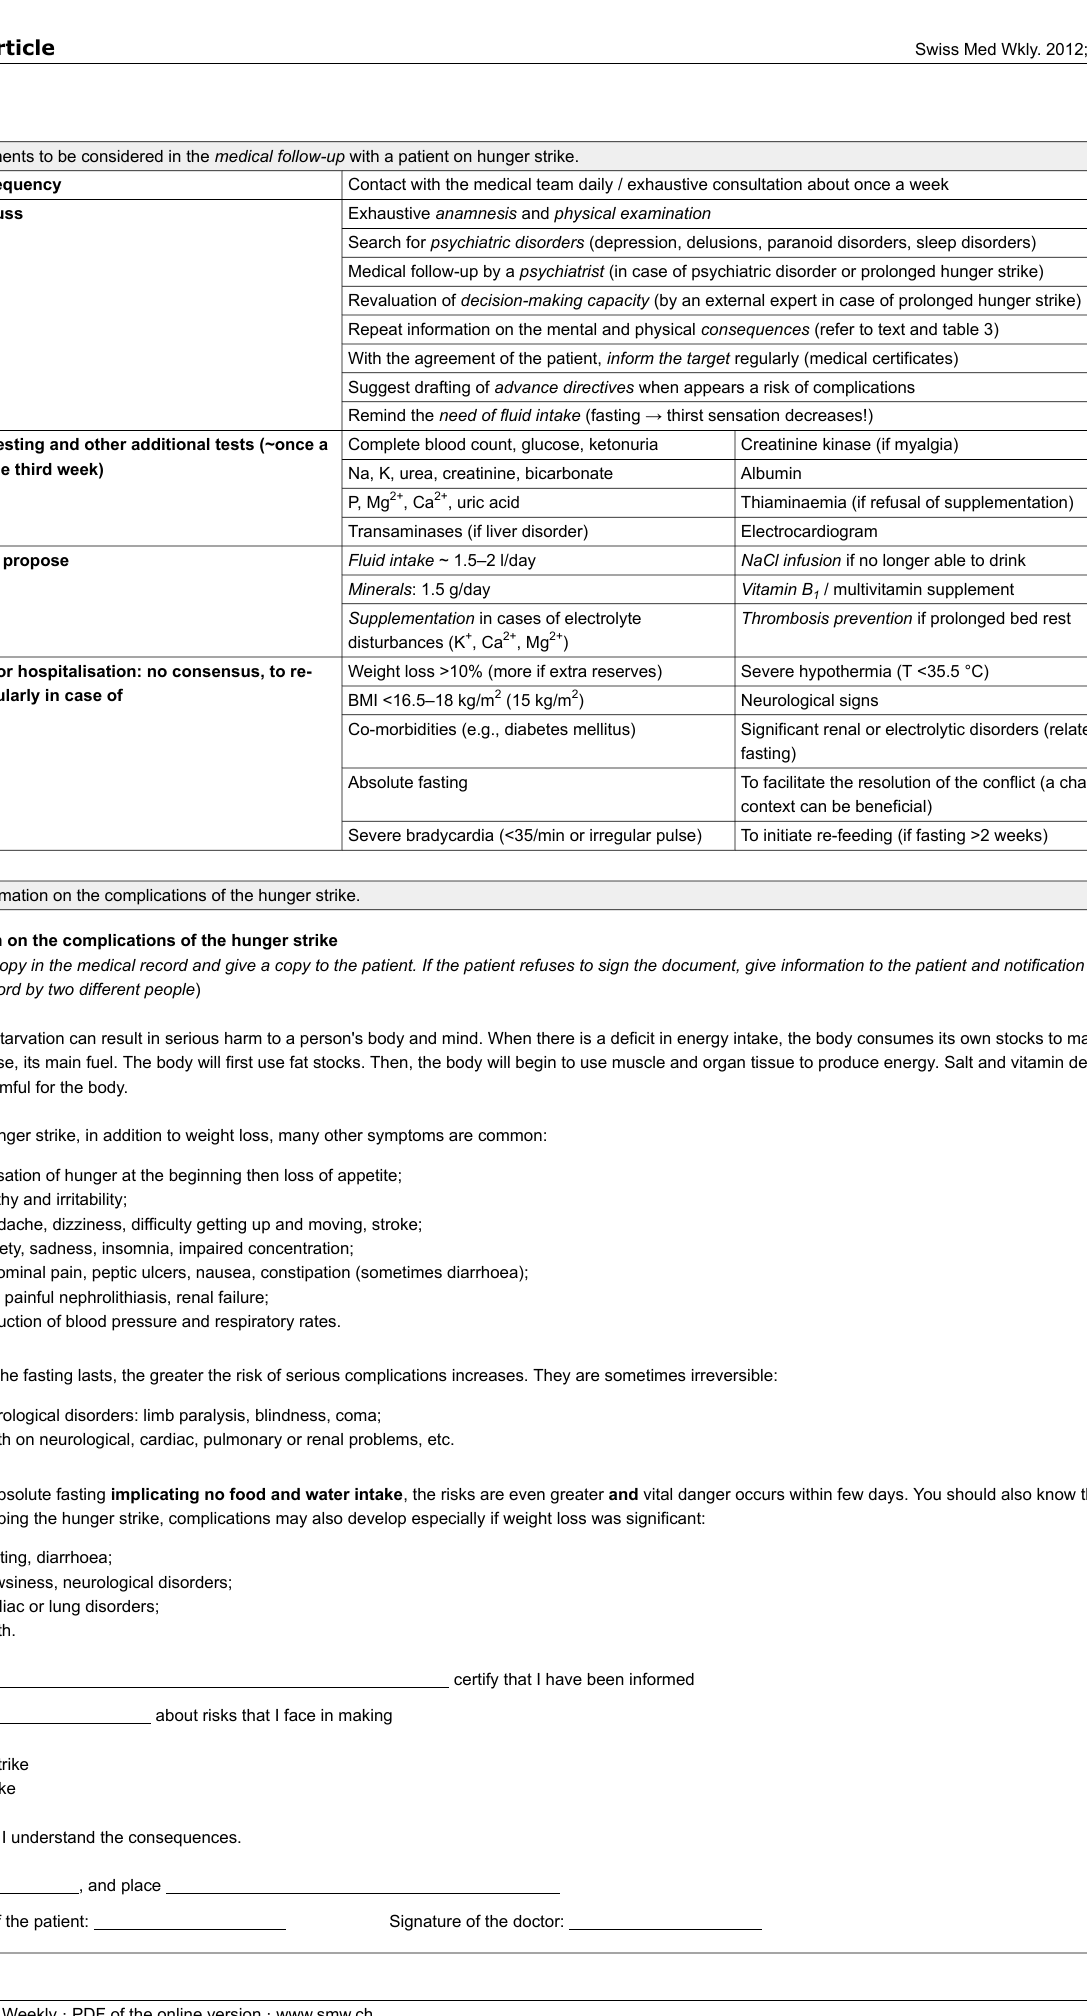
Table 2: Elements to be considered in the medical follow-up with a patient on hunger strike.